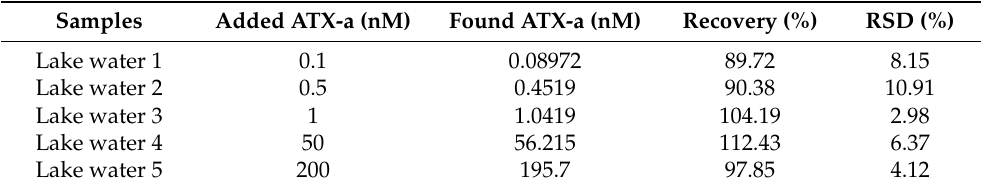
Table 2. Determination of anatoxin-a (ATX-a) concentration in spiked lake water samples using our developed colorimetric aptasensor ( n =